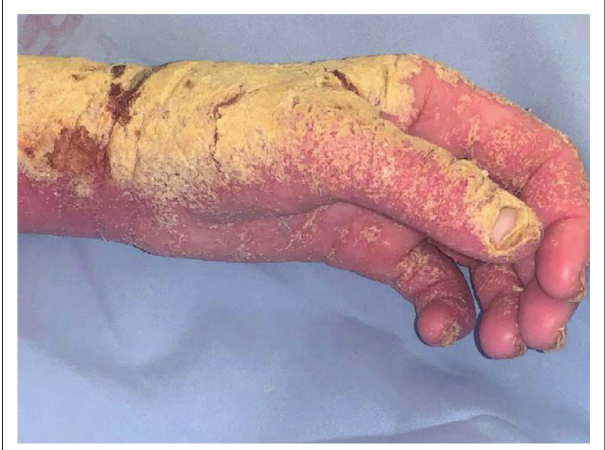
FIGURE 6: Crusted scabies in an albino patient, note the subungual hyperkeratosis.